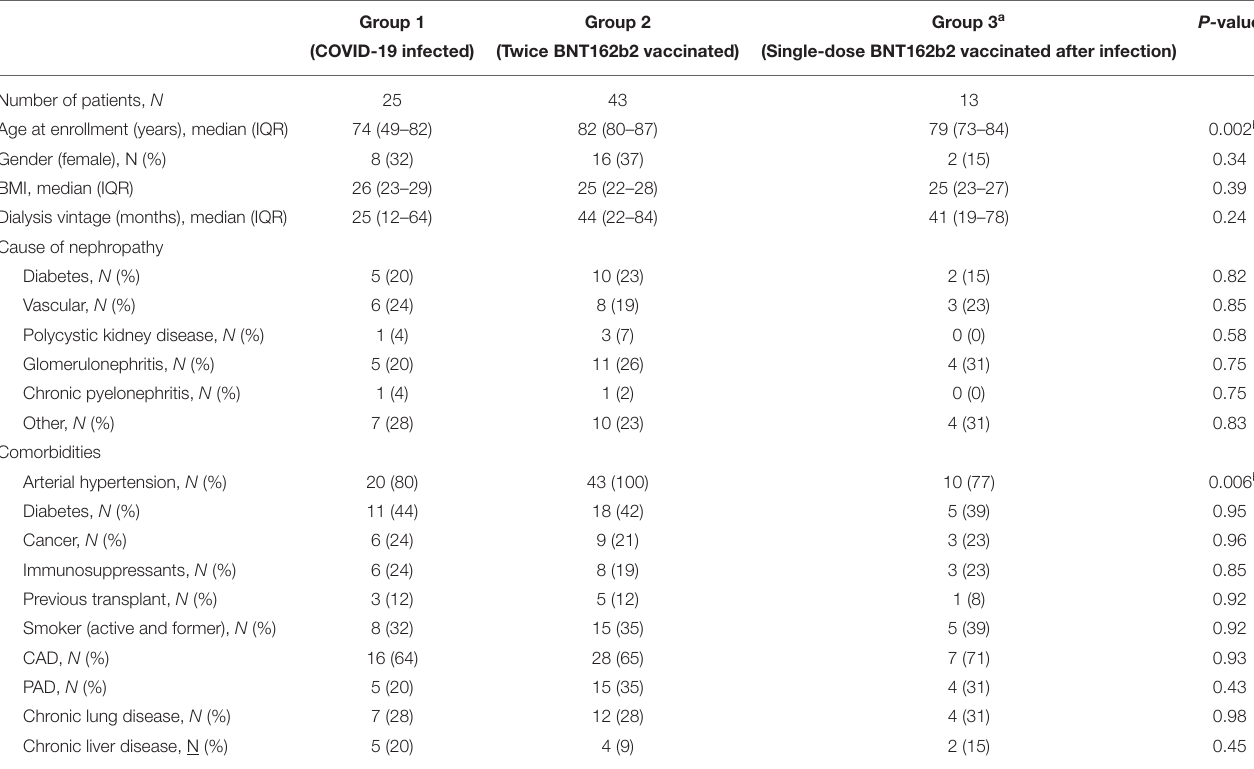
TABLE 1 | Baseline characteristics of participating dialysis patients. Group 1 Group 2